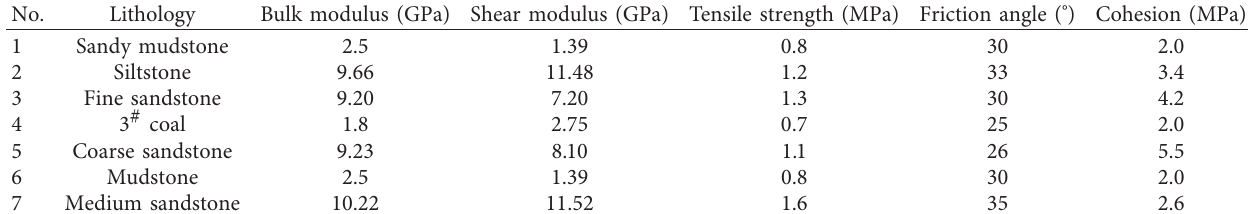
Table 2: Mechanical parameters of coal and rock formations.